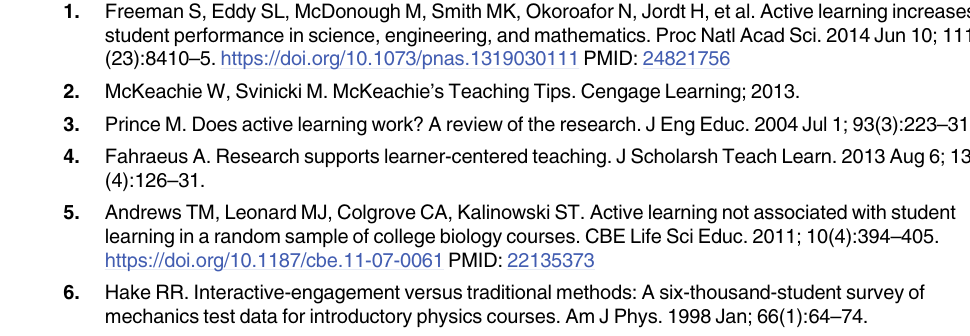
S1 Table. Pearson correlations between secondary instructor and student subscales and RTOP across all